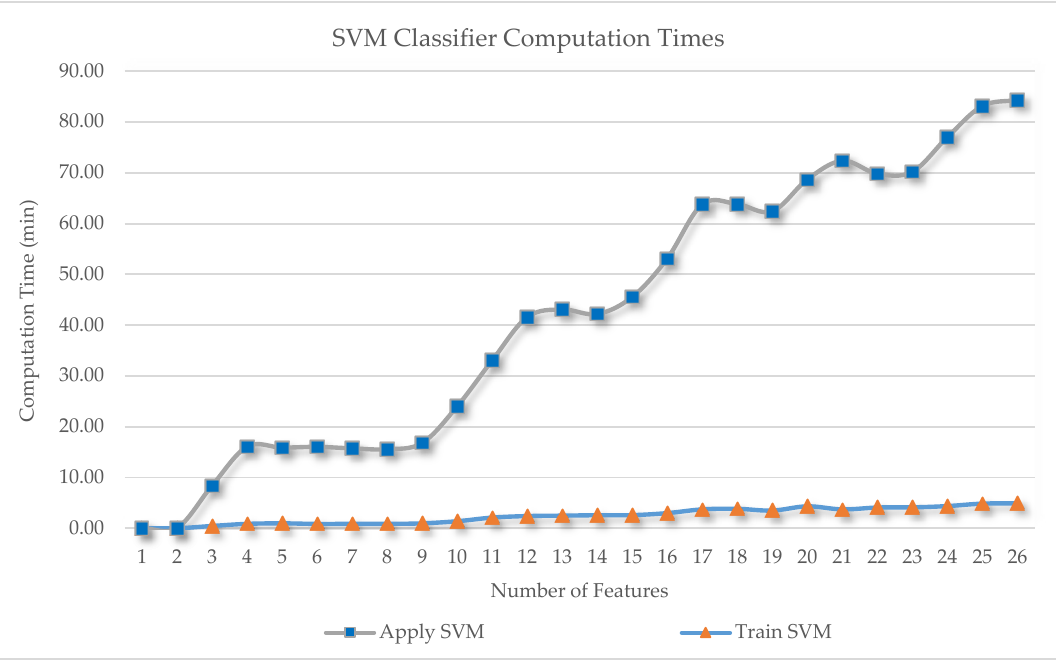
Figure 8. Computation times for the 26 classification schemes as a function of the number of features involved.